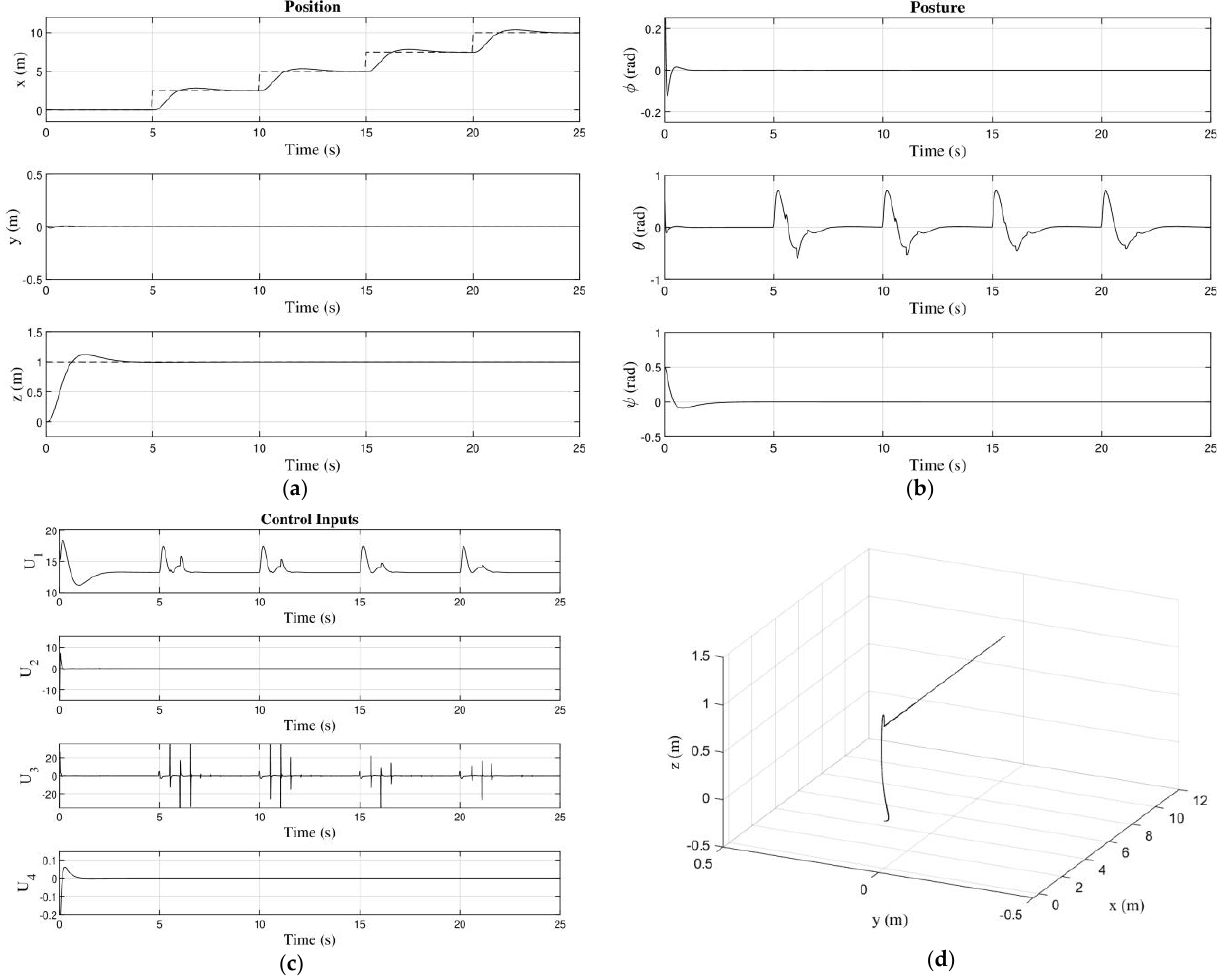
→ f is used as a reference: ( a ) motion control; ( b ) attitude 1